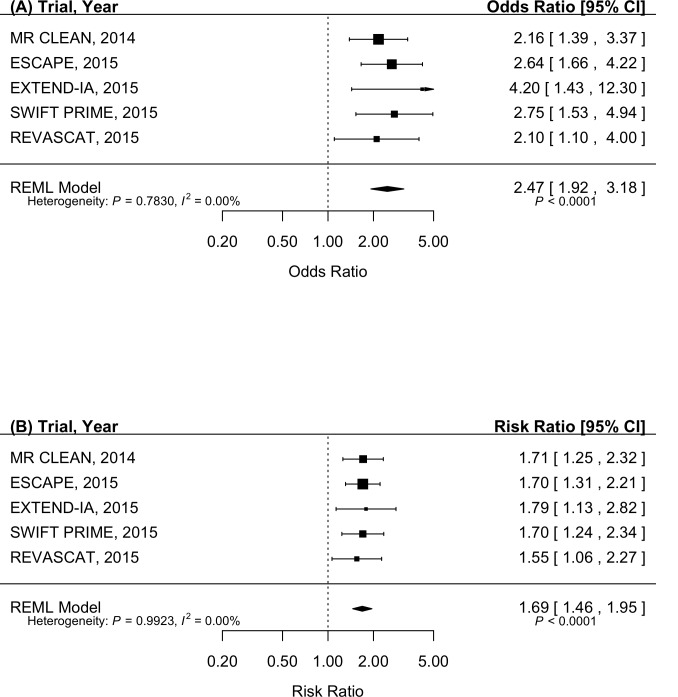
Forest plots of meta-analyses for pooled odds ratios and risk ratios for functional independence (modified Rankin Scale scores of 0 to 2).Patients randomized to endovascular intervention with retrievable stents have (A) 2.47 (95% CI: 1.92 to 3.18) times greater odds and (B) 1.69 (95% CI: 1.46 to 1.95) times greater probability of experiencing functional independence at 90-days post-stroke compared to those randomized to medical management.